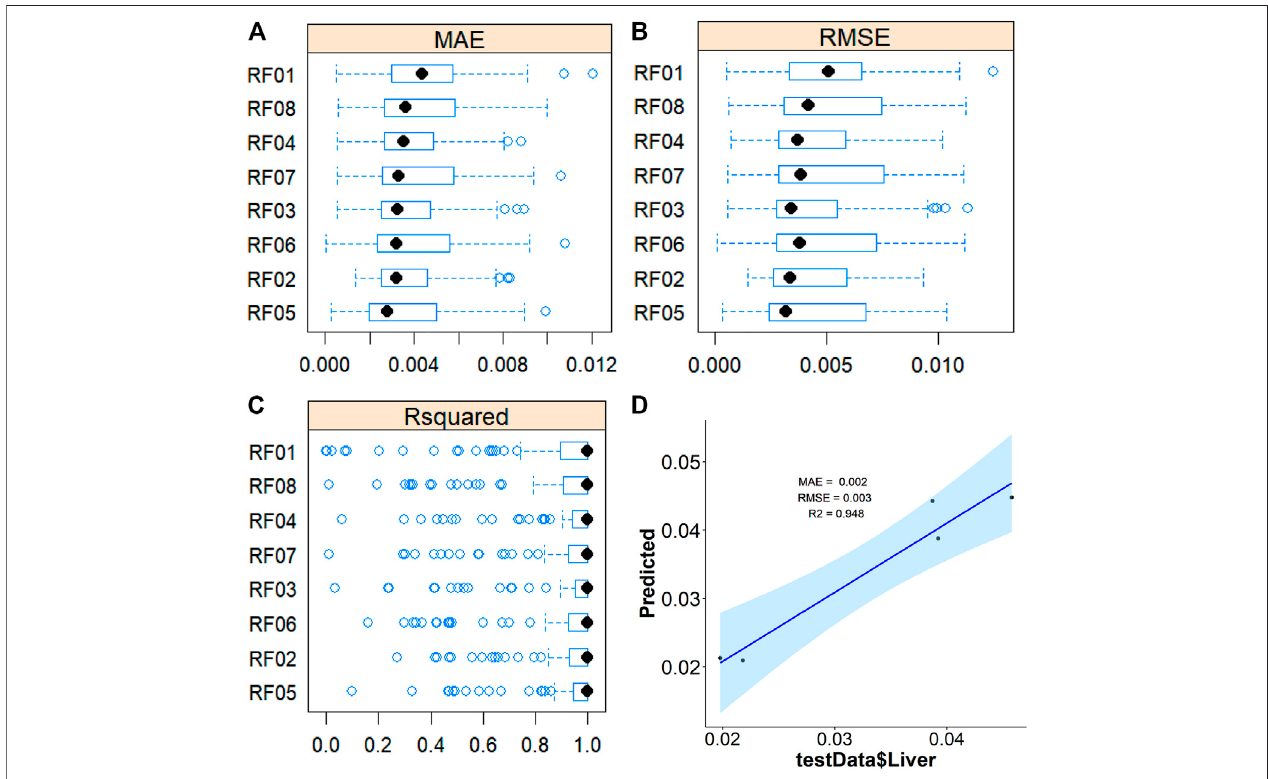
FIGURE8| Average MAE (A) ,RMSE (B) , and R 2 (C) on 10repeated 10-fold cross-validation ofrandomforestmethod withadifferentsubset ofthemetabolomics data for prediction of the liverindex from the train data set. (D) , the linear regression between the original liver index with the predicted liver index by the RF method in the testing data